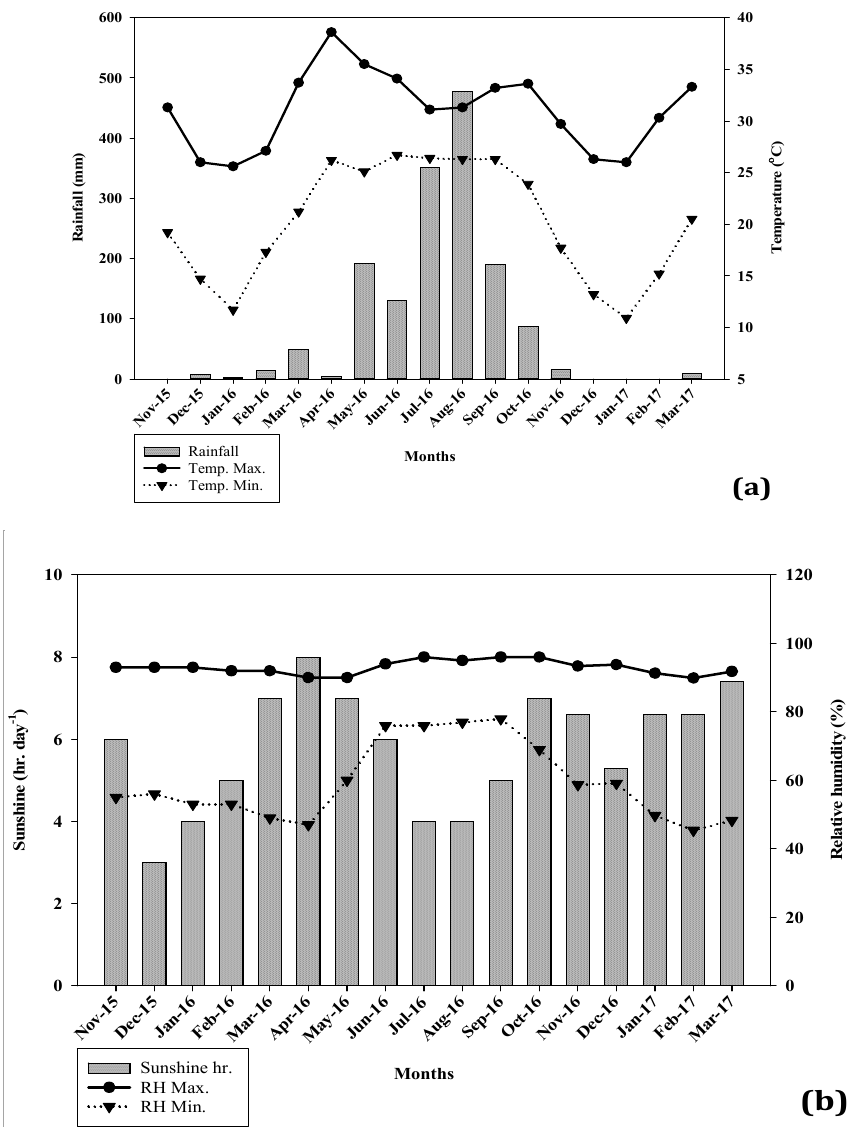
Figure 1. Monthly average rainfall and temperature ( a ), and sunshine hours and relative humidity ( b ) at the experimental site from winter 2015–2016 to winter 2016–2017.